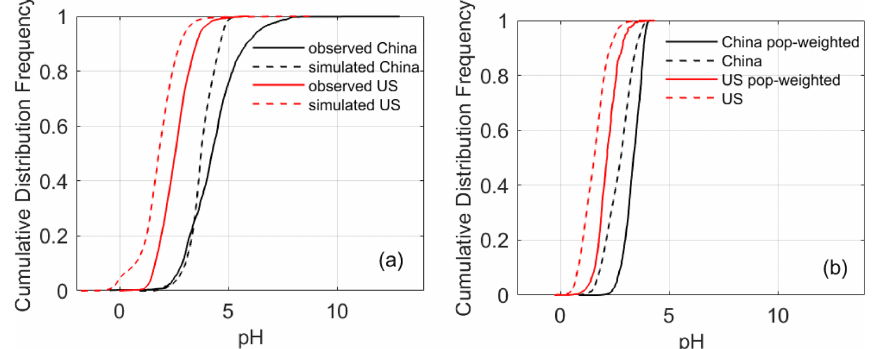
Figure 2. The cumulative distribution function (CDF) curves of aerosol pH in China and the United States based on (a) observed partic- ulate and gaseous composition (solid lines) and CMAQ simulations collocated with observation sites (dashed line) and (b) simulated data nationwide. In panel (b) , both average and population-weighted CDFs are shown.